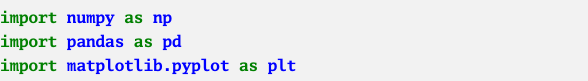
Five main types of data are used in Thermobar (Table 1): ∗ see